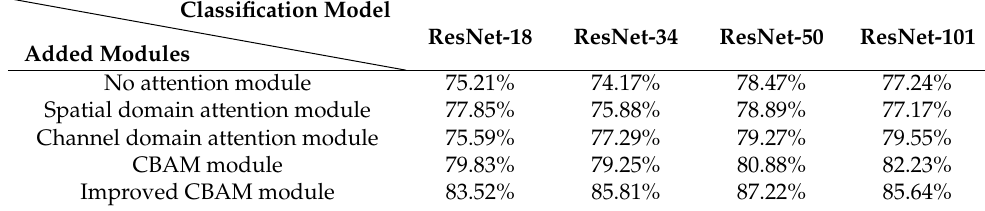
Table 7. Accuracy rates of classification models under each attention mechanism.